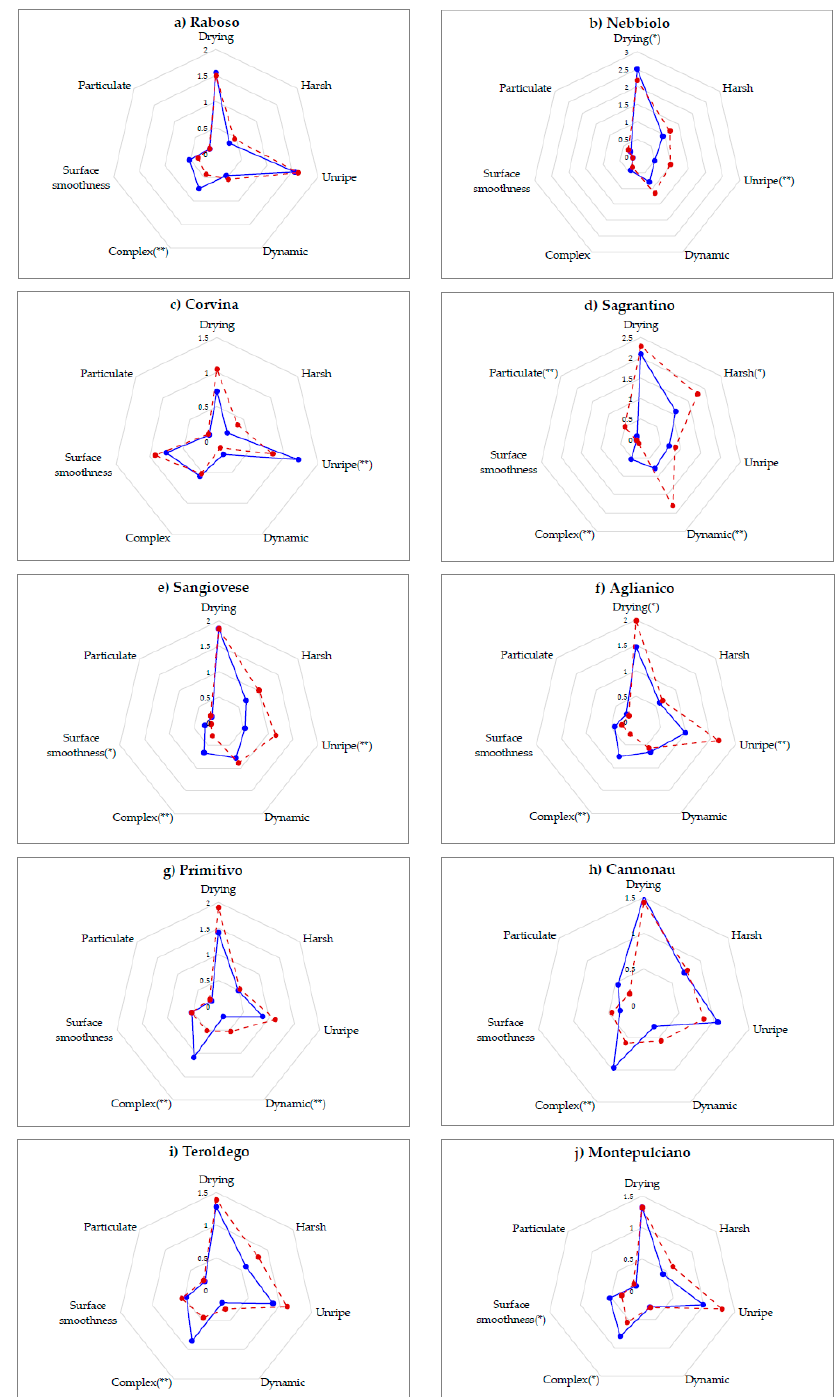
Figure 2. Spider-plots illustrating the impact of the deodorization on astringency sub-quality profile of each of the 10 single-varietal wines: ( a ) Raboso, ( b ) Nebbiolo, ( c ) Corvina, ( d ) Sagrantino, ( e ) Sangiovese, ( f ) Aglianico, ( g ) Primitivo, ( h ) Cannonau, ( i ) Teroldego and ( j ) Montepulciano. Significant differences assessed in WWs (blue line) and corresponding DWs (broken red line) are marked with asterisks (* p < 0.1, ** p < 0.05).